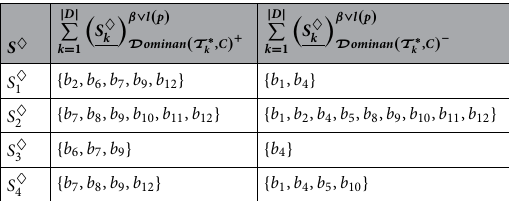
Table 10. The lower approximations with β = 0.90, l = 1 .